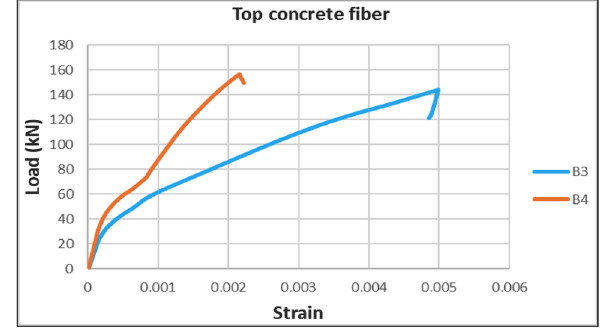
Figure 10: Strain in top concrete fi ber for specimens beams B3 and